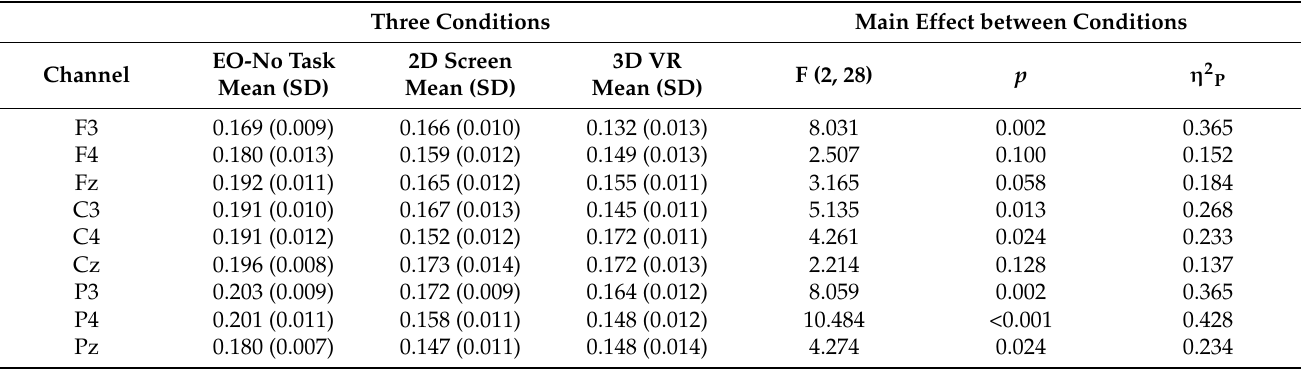
Table 3. Relative EEG theta power for the three conditions EO-no task, 2D screen and 3D VR.